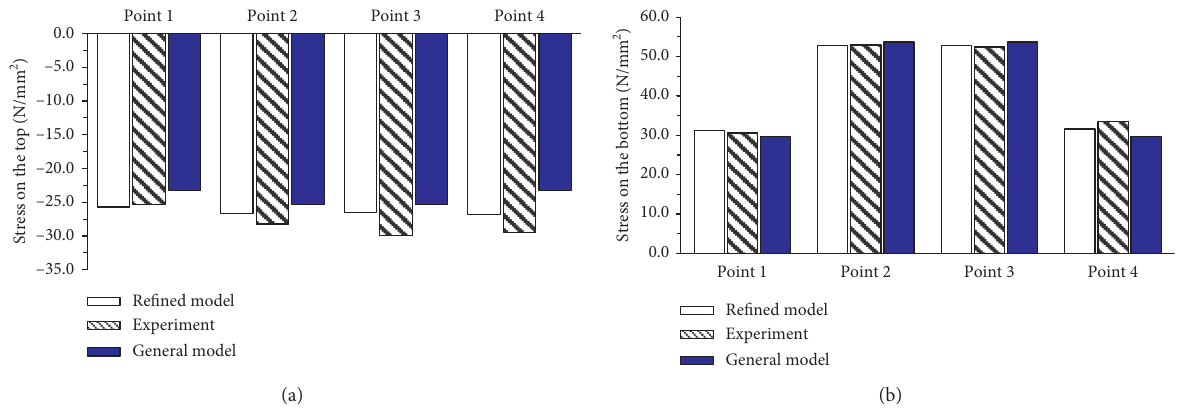
Figure 24: Comparison of the stresses between the experiment and FE models. (a) Top surface. (b) Bottom